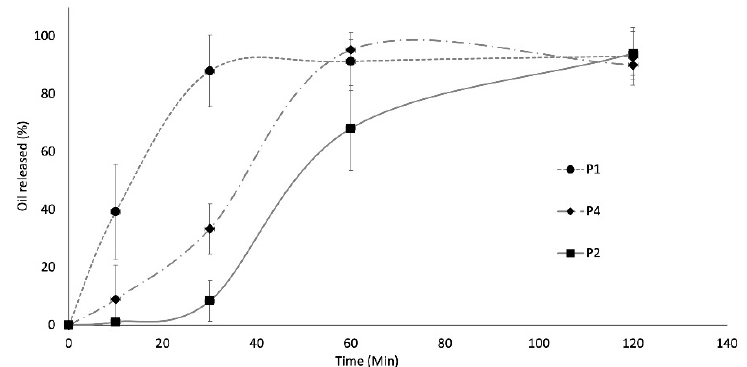
Figure 5. In vitro essential oil release profile of the systems.